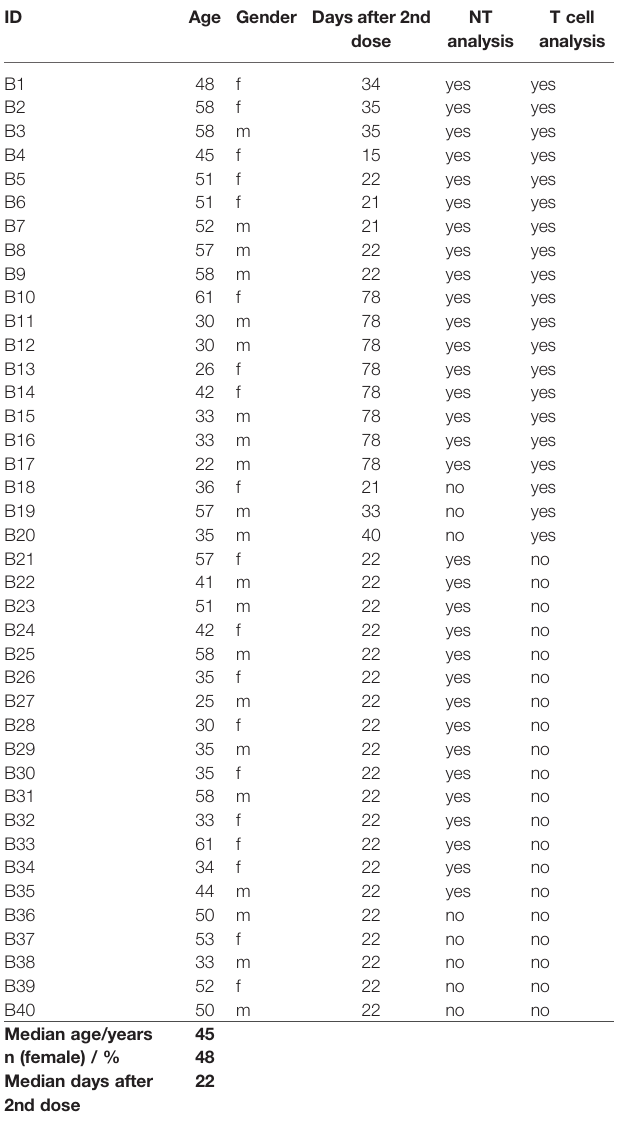
Age, sex, and sampling day after the second vaccine dose are shown. Serum samples used for the neutralization experiments are labeled in column ‘ NT analysis. ’ PBMCs used for ELISpot assays are labeled in column ‘ T cell analysis. ’ The average age of the participants was 44 years. The percentage of women was 48%. All samples of BNT162b2 vaccinees younger than 60 years were taken between 15 and 78 days after the second